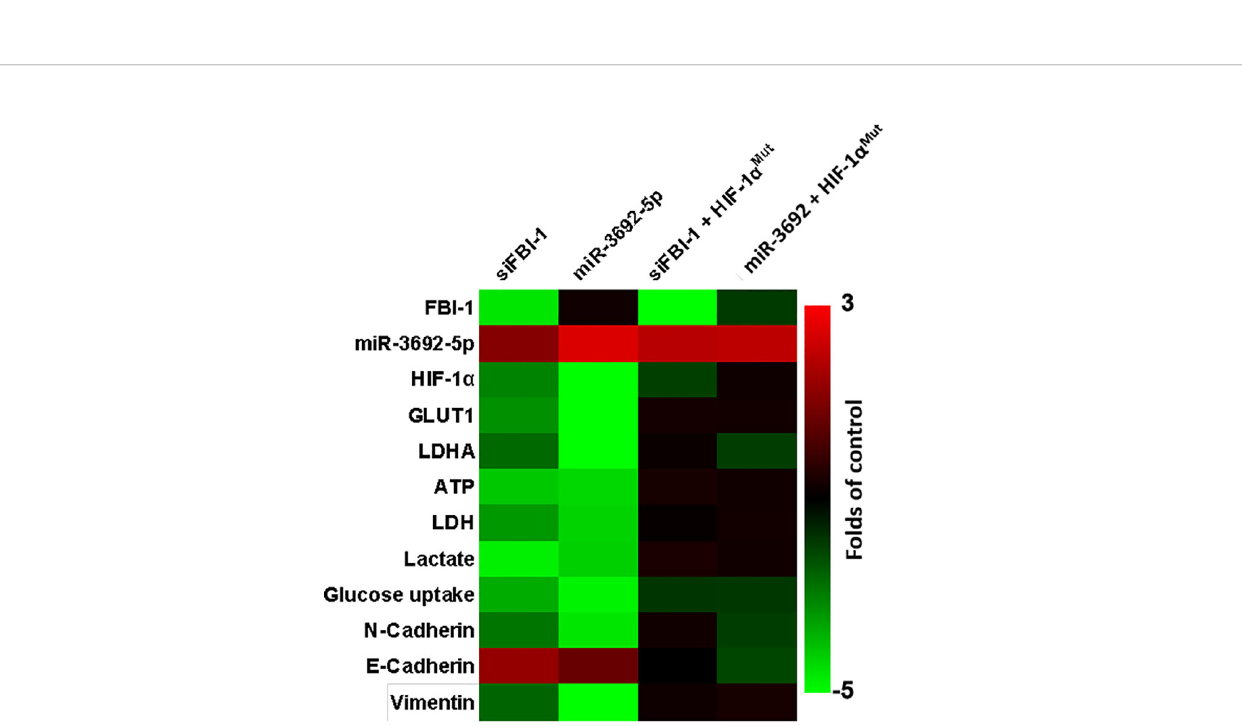
FIGURE 4 | The speci fi city of FBI-1 miR-3692-5p/HIF-1 a . The MHCC97-H cells were transfected with vectors. Cells were measured by qPCR and biochemical analysis. The results are shown as